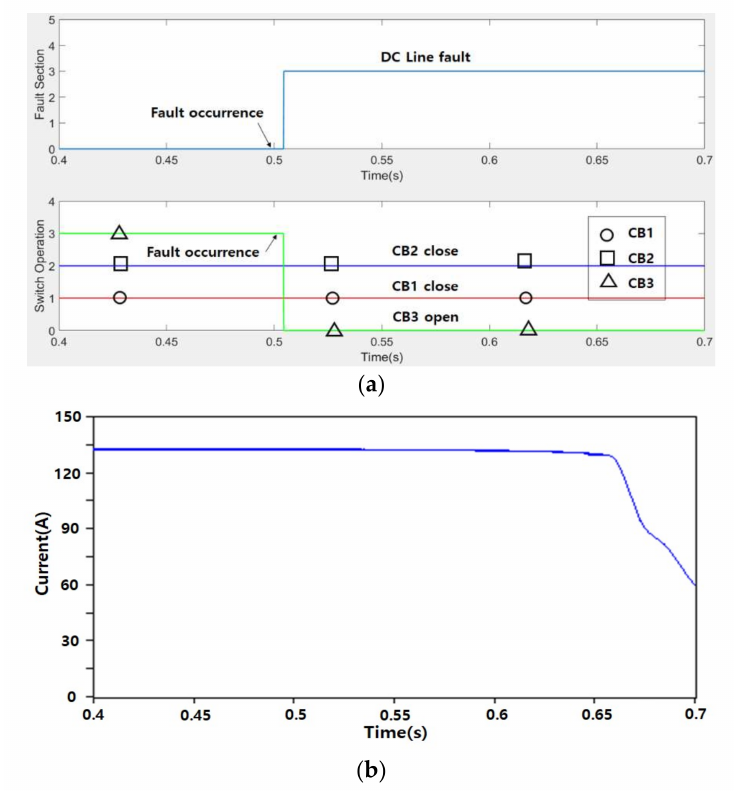
Figure 23. Simulation results of Case 9: ( a ) Fault section and CB operation and ( b ) Load